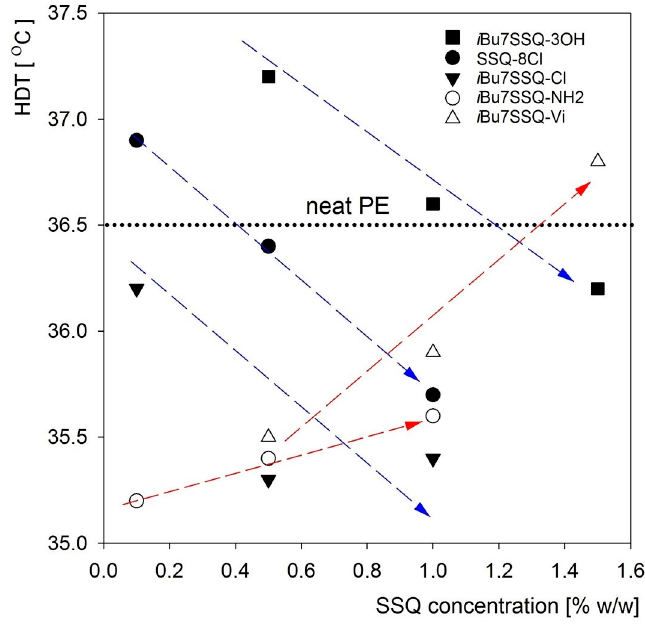
Figure 4. Heat Deflection Temperatures of the obtained composites.